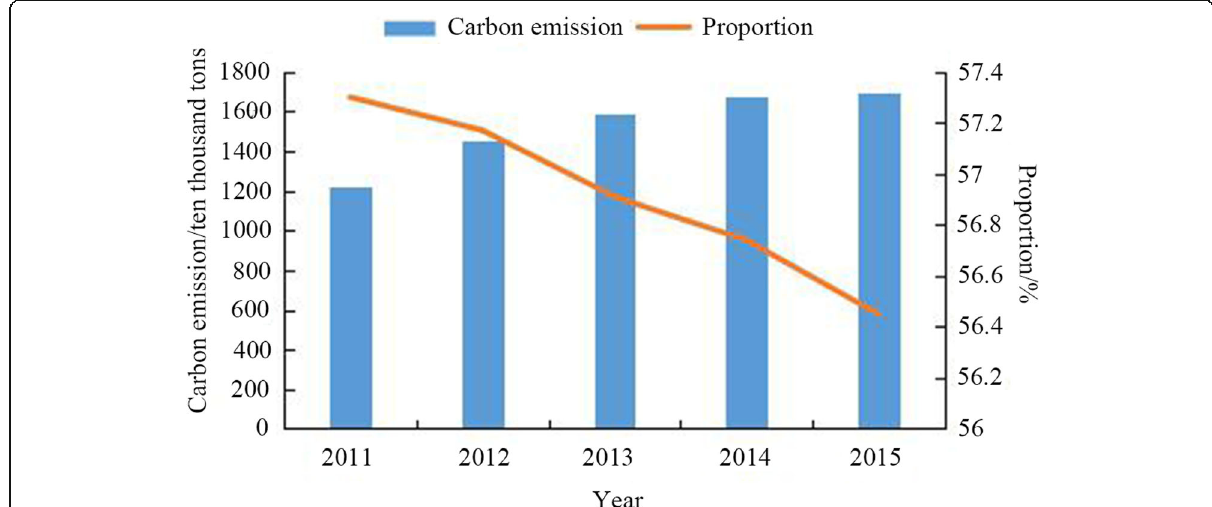
Fig. 3 Changes of carbon emissions of wholesale, retail, accommodation, and catering